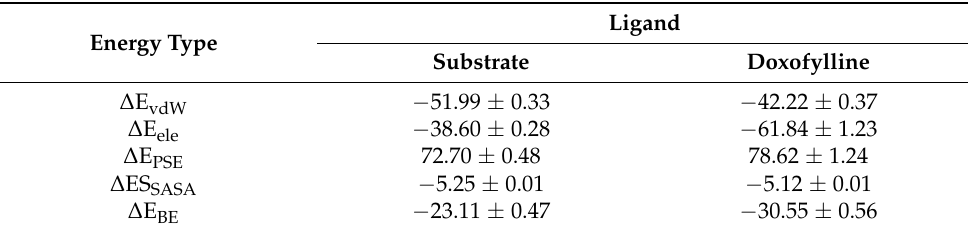
Table 4. Binding free energy of substrate and doxofylline with lysozyme calculated by the MM-PBSA method for 100 snapshots of MD